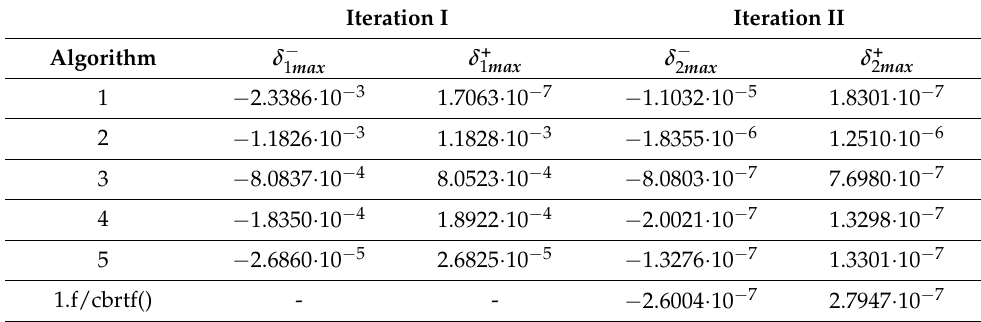
Table 1. The maximum negative and positive errors of two iterations for different